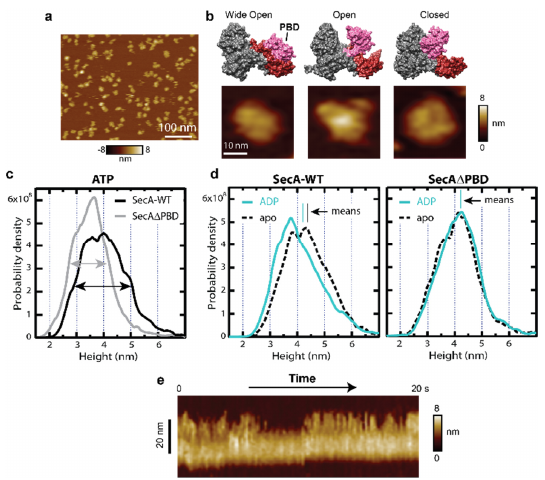
Figure 2. SecA dynamics and nucleotide-dependent topographical states. (a) AFM image of wild type SecA (SecA-WT) on mica in buffer conditions which favor monomer. ( b ) Structures of SecA in different conformational states are shown: the wide-open from B. subtilis (1M6N; left), open state from B. subtilis (1TF5; middle), and closed state from T. maritima (3DIN; right). The PBD and C-terminal segments are colored pink and red, respectively; all other domains are gray. Detailed AFM views of three SecA molecules exhibiting conformational differences are shown below the structures. ( c ) Height histograms for SecA-WT ( N = 2437) and SecA ∆ PBD ( N = 1458) in the presence of ATP. The FWHM (indicated with arrows) of the SecA-WT is 23 Å compared to 15 Å for the SecA ∆ PBD. ( d ) Height distributions for SecA-WT (apo: N = 3726; ADP: N = 6428) and SecA ∆ PBD (apo: N = 4009; ADP: N = 3104) in the presence and absence of ADP. Vertical lines show the means of the distributions. Only one mean is visible for SecA ∆ PBD because the apo and ADP means are identical to within uncertainty. ( e ) Kymograph of SecA-WT in saturating ATP over 20 s. The interval between adjacent line scans was ∆ t = 95 ms. Data are adapted from Ref.